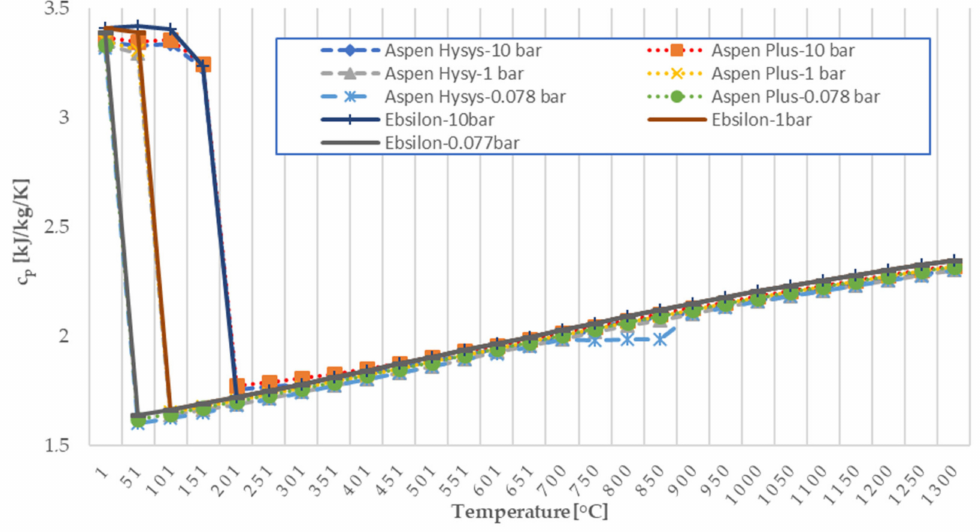
Figure 13. Distribution of heat capacity at constant pressure per temperature after WCC at different pressure in Aspen Hysys, Aspen Plus, and Ebsilon.